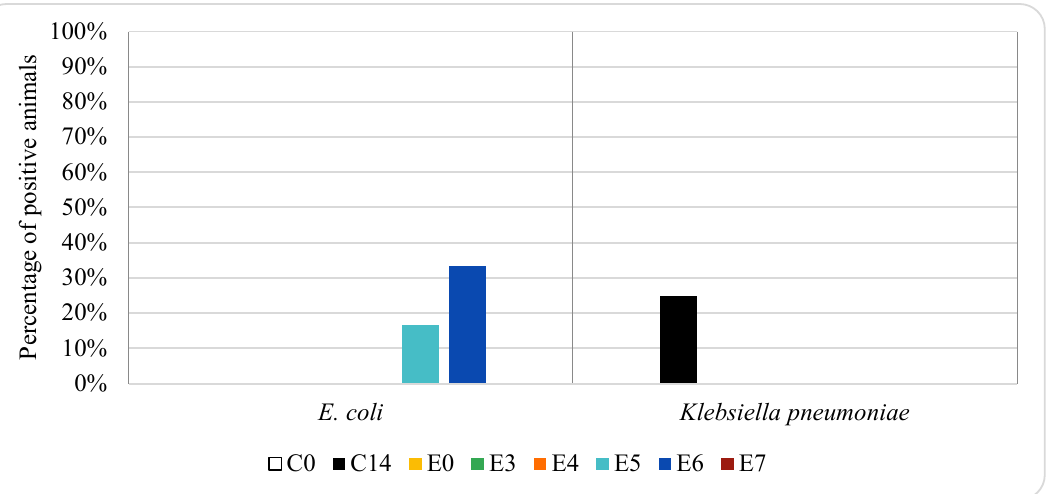
Figure 7. Effect of oxytetracycline treatment on ESBL-producing K. pneumoniae in pig genital sam- ples. For group descriptions, C0, C14, T0, T6, T13, T15, T17 and T19: see Table 1.